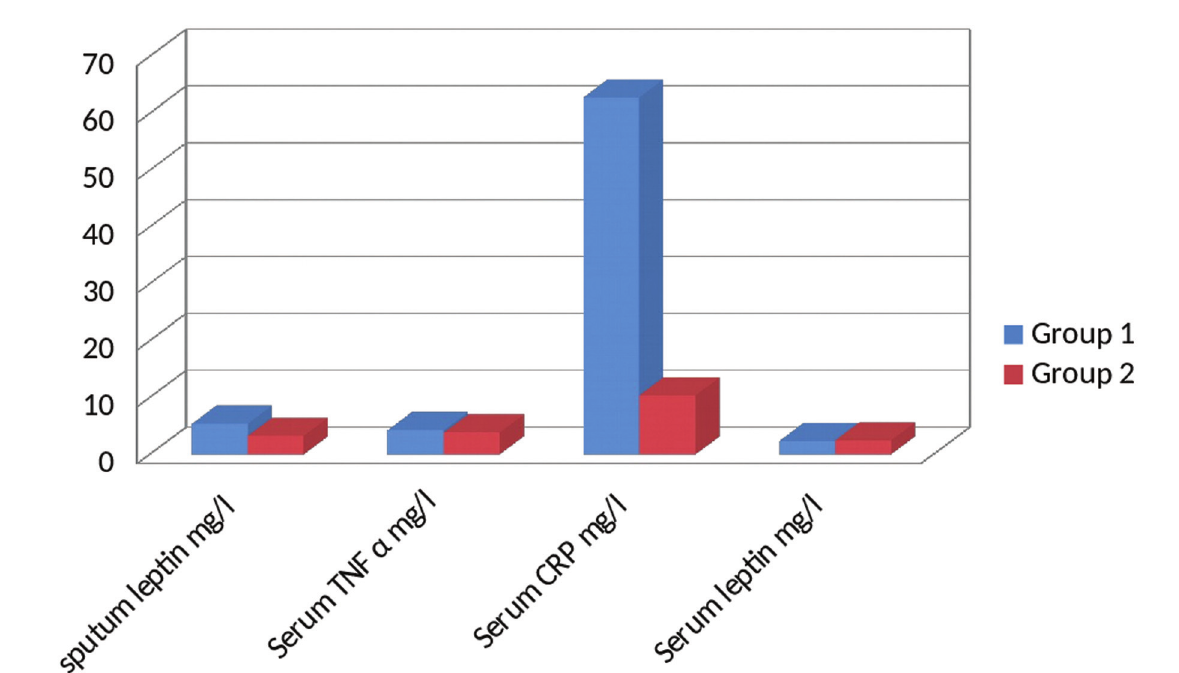
Correlation between mean sputum leptin, serum TNF- α , CRP, and leptin levels in group 1 and group 2. CRP, C-reactive protein; TNF- α , tumor necrosis